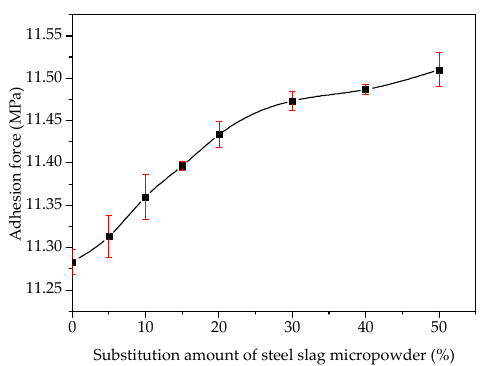
Figure 6. Effect of freeze–thaw cycles on the adhesion at the asphalt–steel slag interface.